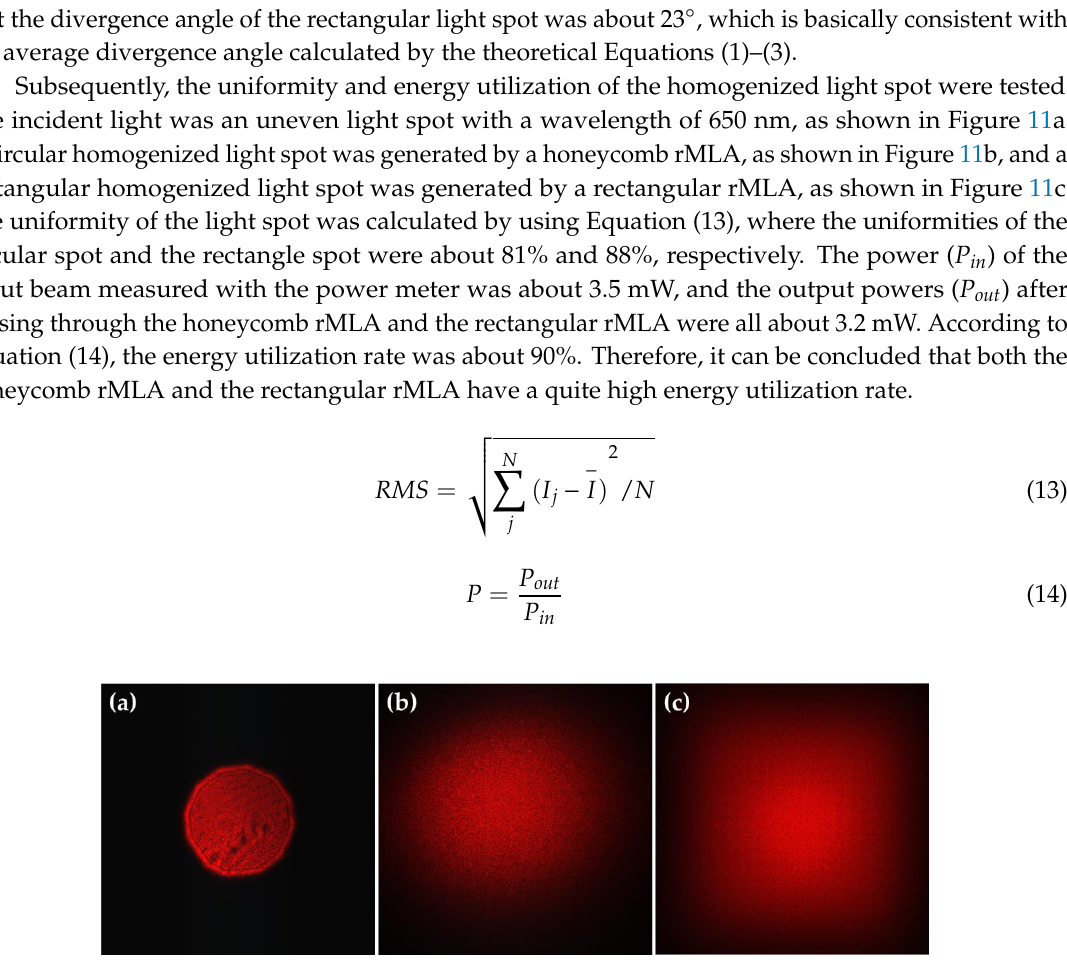
Figure 11. Homogenization spot effect collected by CCD: ( a ) the incident laser beam; ( b ) the circular homogenization spot reconstructed by the honeycomb rMLA; and ( c ) the rectangular homogenization spot reconstructed by the rectangular rMLA.